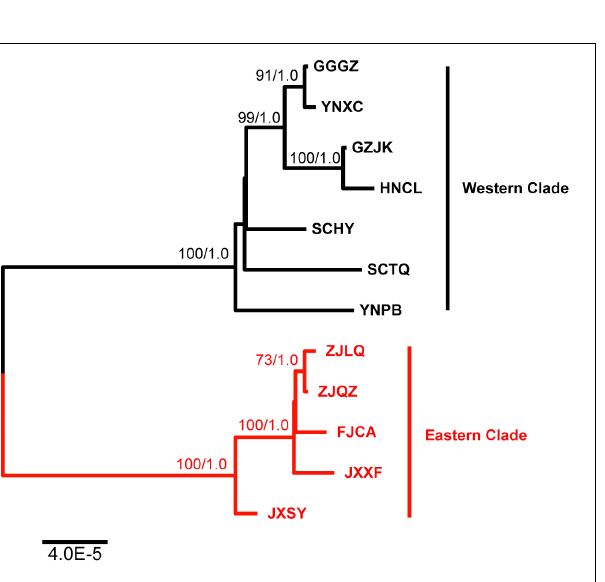
FIGURE 8 | Phylogenetic relationships among B. sinensis samples. ML topology is shown with the ML bootstrap support value and Bayesian posterior probability at each node. ML values < 50 and BI values < 0.7 were not